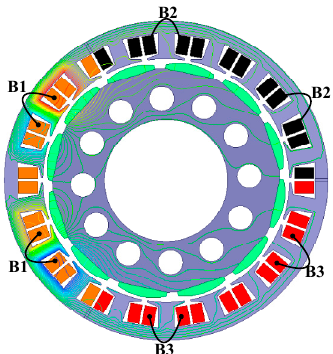
Figure 6. Armature reaction of the winding B1.